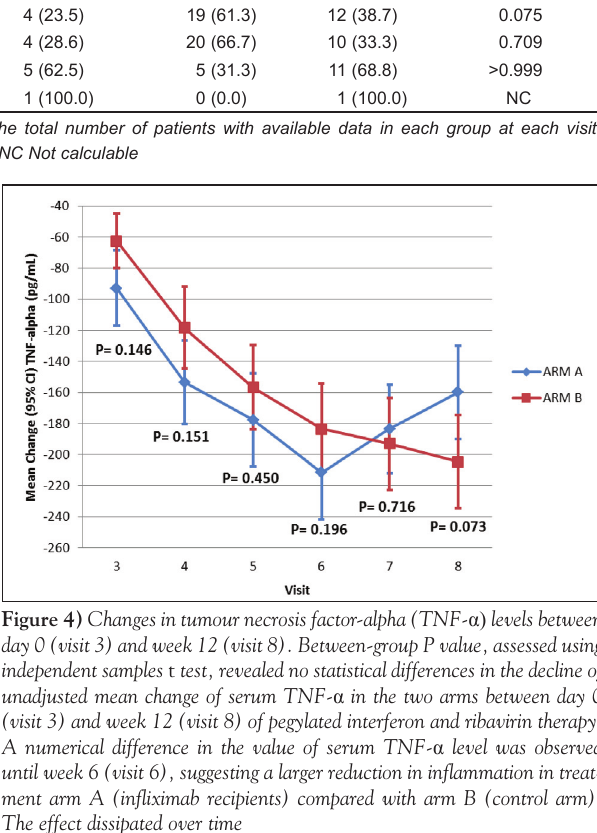
Table 3 Complete early virological response according to fibrosis score – intent to treat Fibrosis